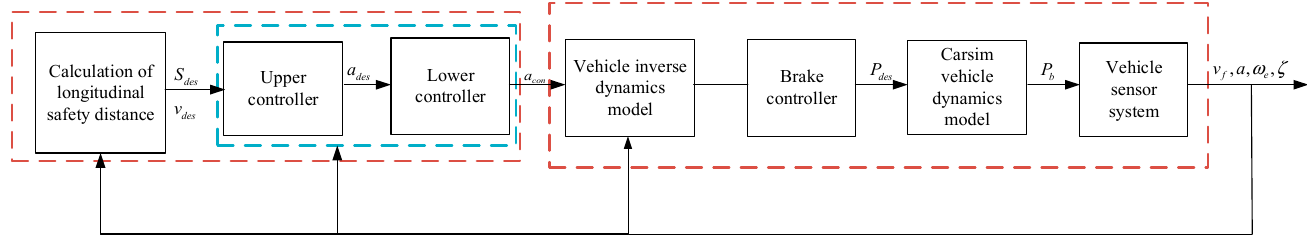
Figure 1. Overall system structure of active collision avoidance control. The Blue circles represent the controller.The red square frame on the left side of the figure was built by Simulink. Similarly, the red square frame on the right side was built by Carsim. Here, S des represents the expected safety distance; v des represents the autopilot speed; a des represents the desired acceleration; a con represents the controlled quantity of the lower controller; P des represents the expected automatic driving brake pressure; P b represents the actual braking pressure of the car; v f represents the actual vehicle speed; a represents the actual acceleration of the car; ω e represents the engine speed; ζ represents the actual distance between the car and the front